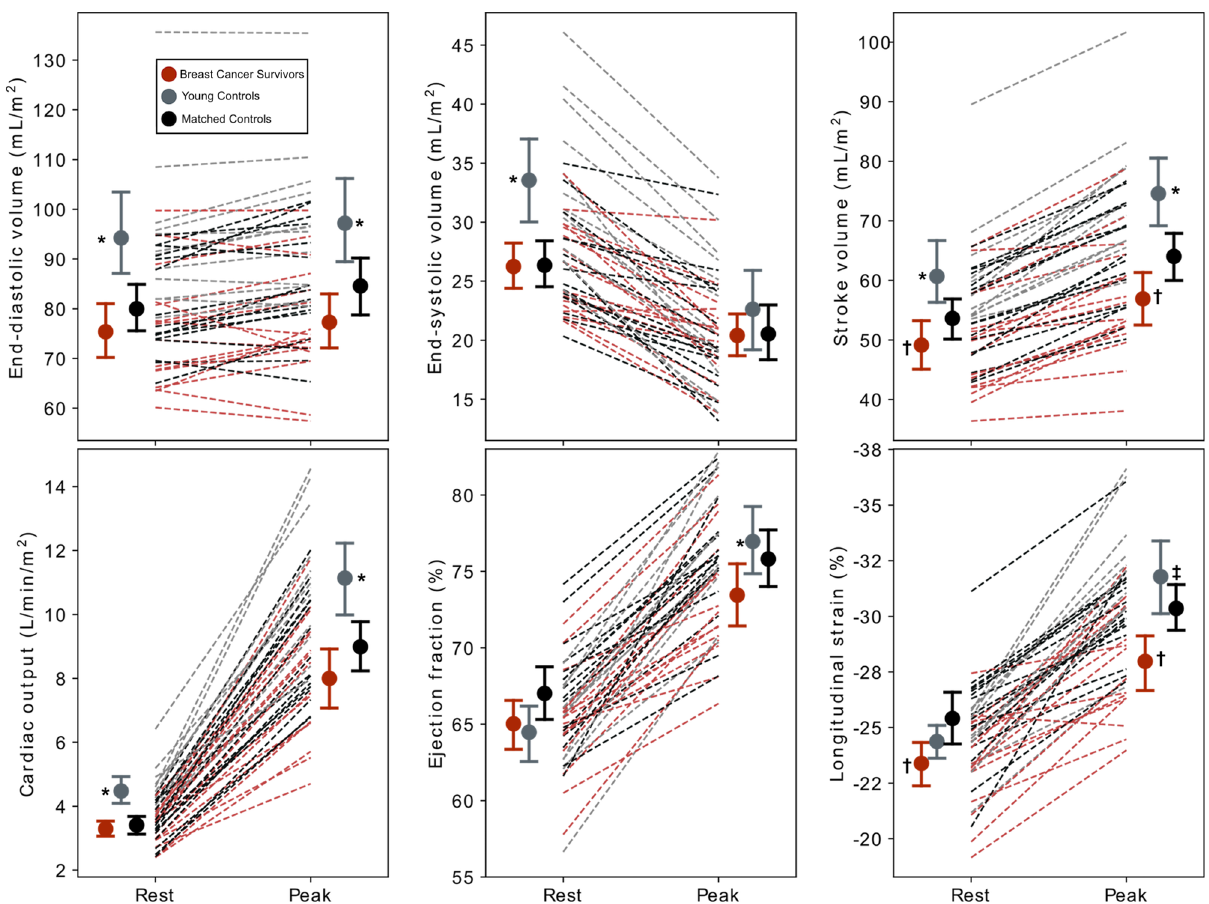
Figure 2. Change and mean cardiac function from rest to peak exercise among anthracycline-treated breast cancer survivors (n = 16), age- and body mass index-matched non-cancer controls (n = 16), and young, healthy controls (n = 12). All data is derived from cardiac magnetic resonance imaging. Volumes are normalized to body surface area. Young controls had larger peak and reserve stroke volume and cardiac output compared to both other groups. Compared to matched controls, breast cancer survivors had lower rest and exercise stroke volume and global longitudinal strain, and cardiac output reserve. *Difference from both breast cancer survivors and matched control groups at p ≤ 0.05; † Difference from matched control group at p ≤ 0.05; ‡ Difference from breast cancer survivor group at p ≤